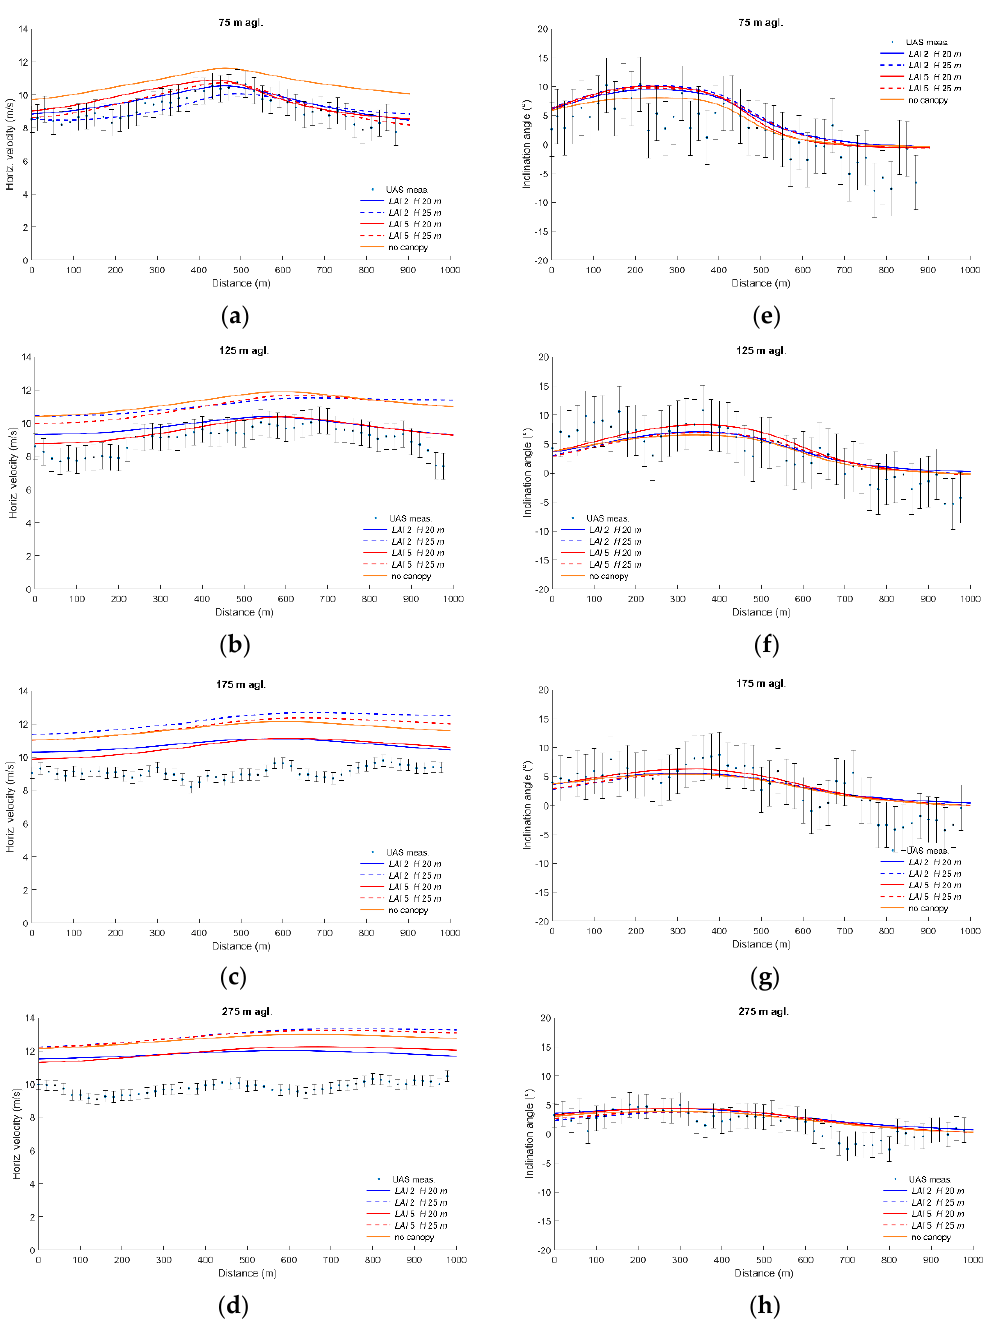
Figure 14. Horizontal velocity ( a – d ) and inclination angle ( e – h ) at 75 m, 125 m, 175 m, and 275 m agl.